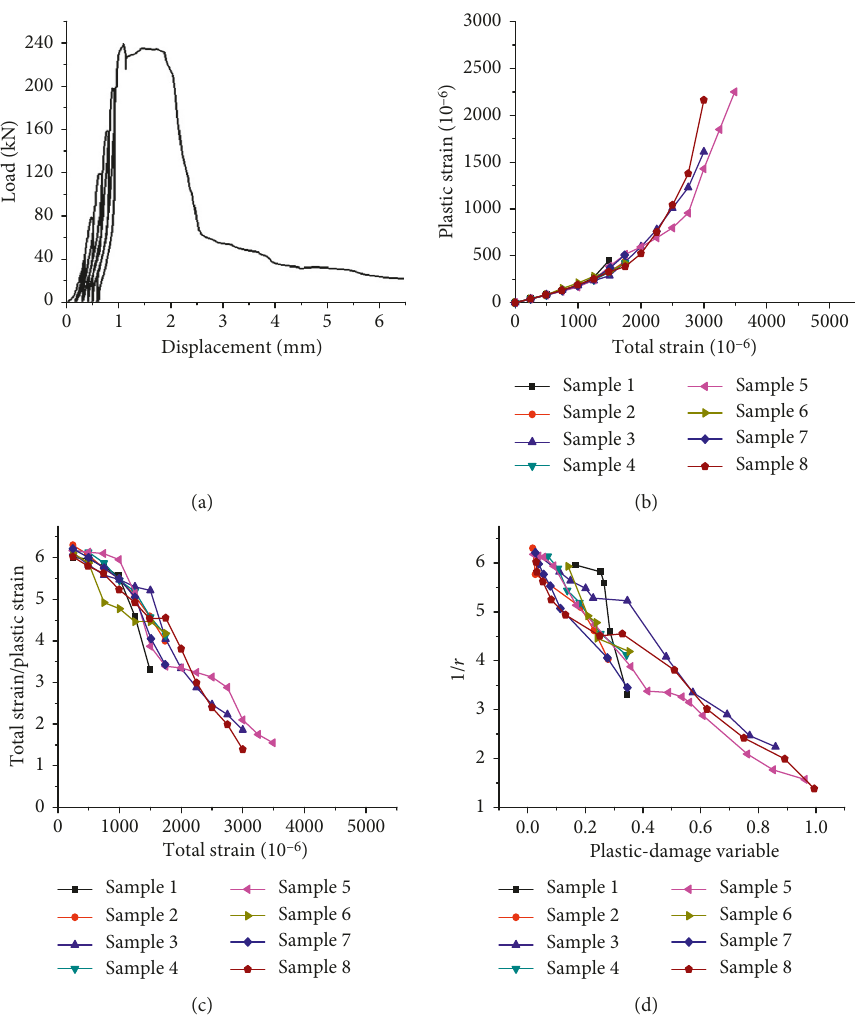
Figure 4: Experimental results of SCC samples under cyclic compression tests. (a) Typical load-displacement relationship (sample 1). − ε . (c) Relationship of ε / ε − ε . (d) Relationship of 1/ r − dr (b) Relationship of ε p p